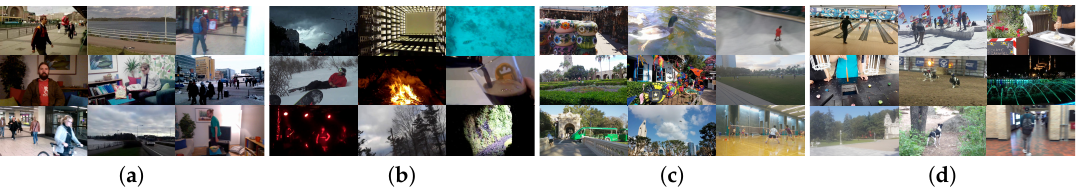
Figure 4. Sample frames of the video contents contained in the four in-capture databases: ( a ) CVD2014, ( b ) KoNViD-1k, ( c ) LIVE-Qualcomm, and ( d ) LIVE-VQC. Table 1. Overview of the publicly available databases for in-capture video quality assessment. In the column Device types : “DSLR” stands for Digital single lens